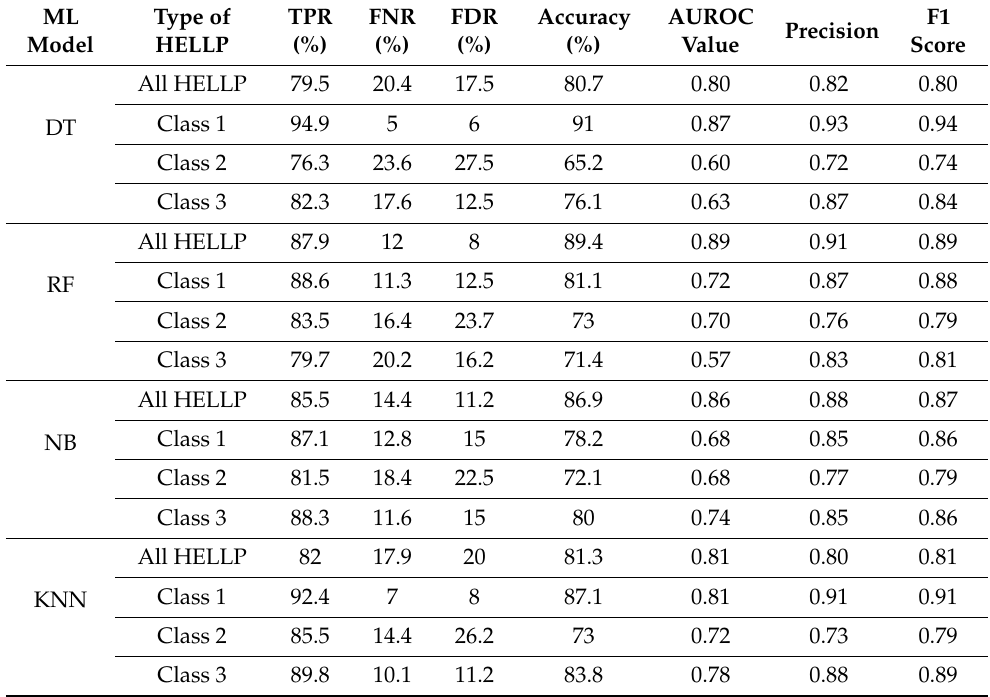
Table legend: All HELLP—all types of HELLP syndrome; ML—machine learning; DT—decision trees; NB—naïve Bayes; KNN—k-nearest neighbors; RF—random forest; TPR—true positive rate; FNR—false negative rate; FDR—false detection rate; AUROC—area under the receiver operating characteristic